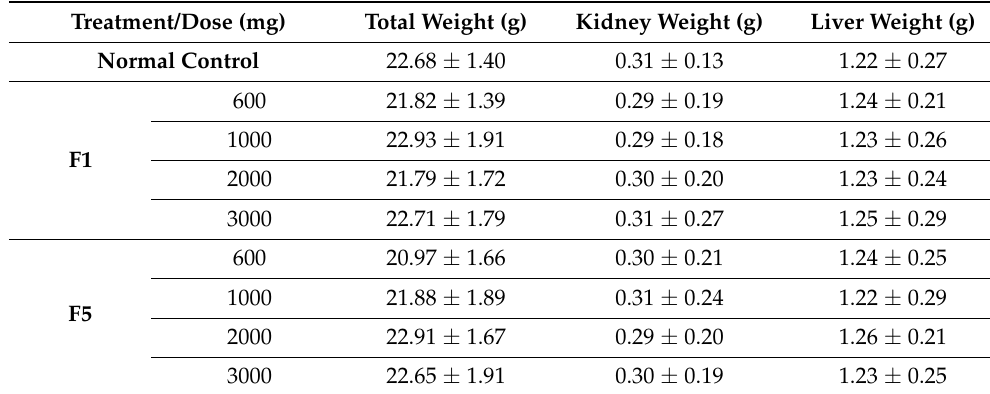
Table 3. Effects on total weight and weight of vital organs in mice measured by acute toxicity study.